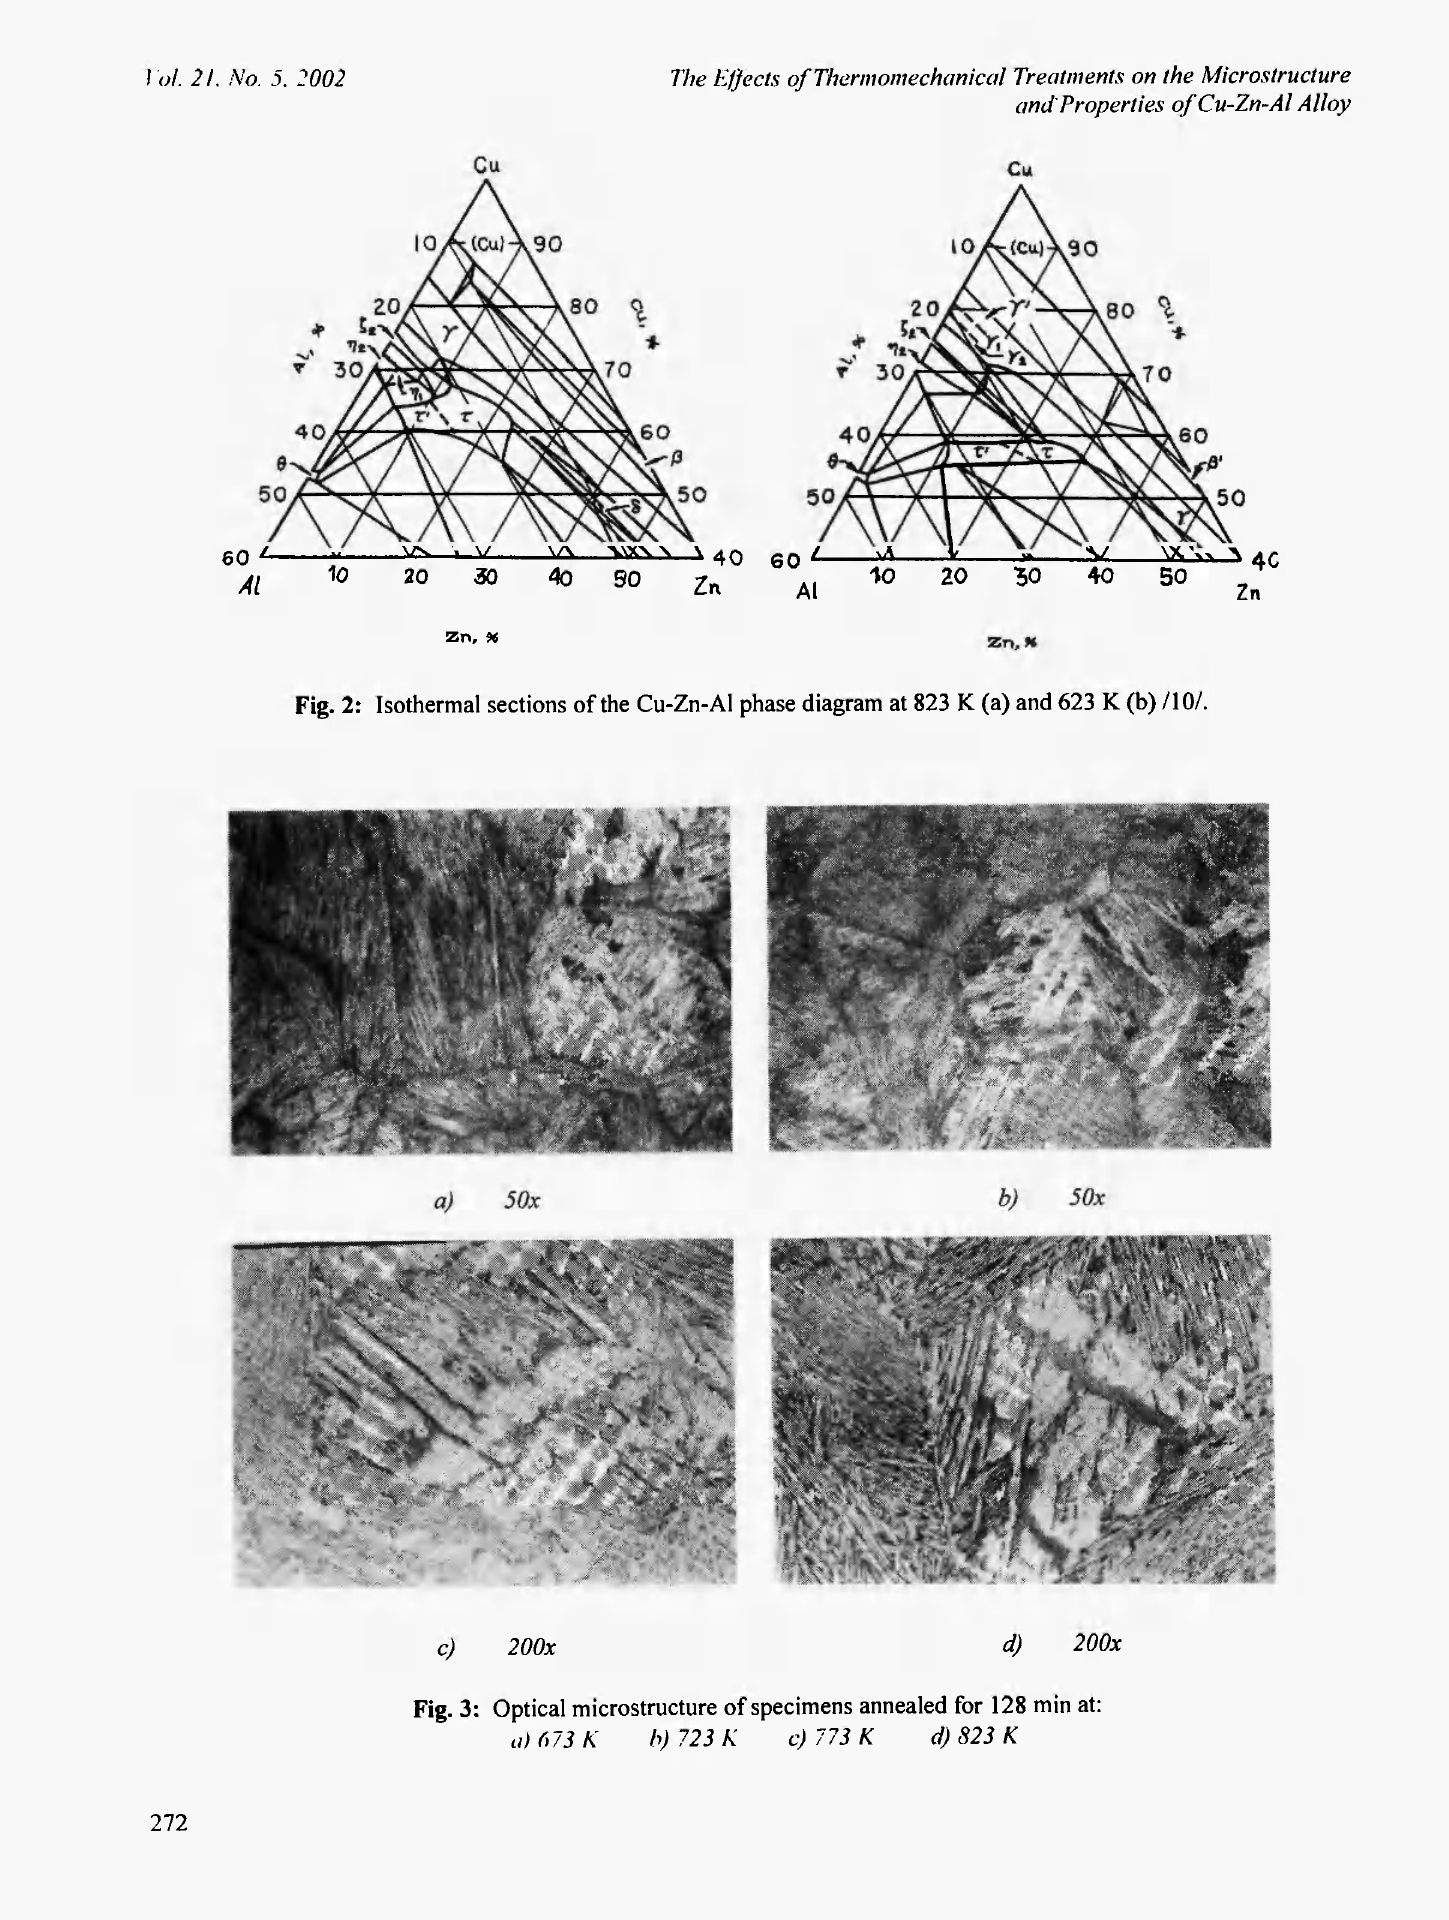
Fig. 3: Optical microstructure of specimens annealed for 128 min